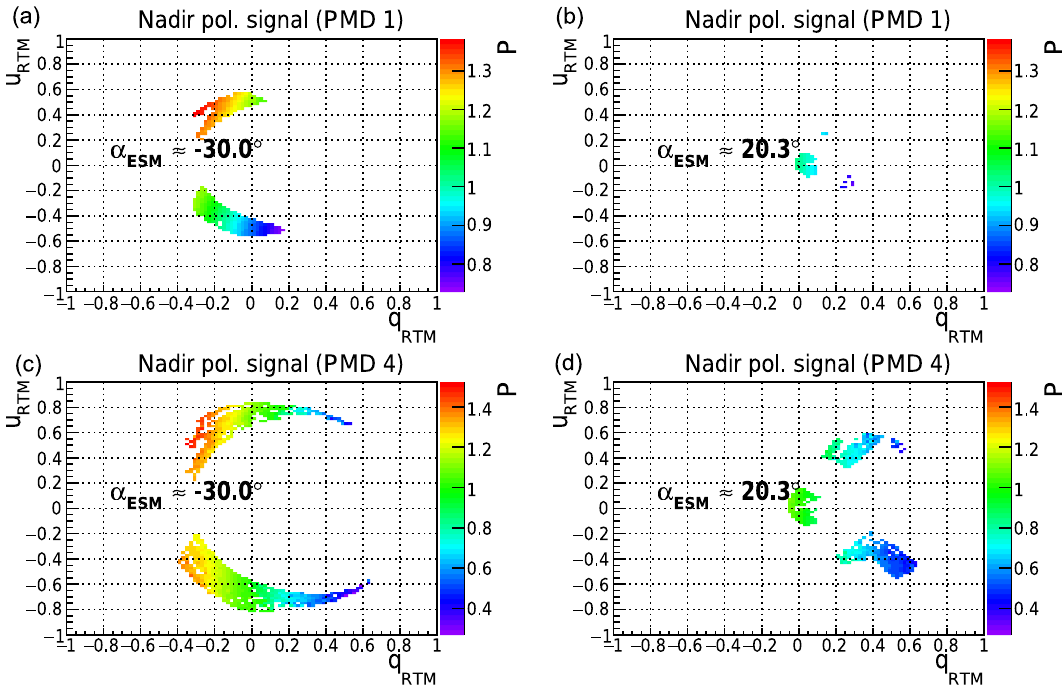
Figure 4. Polarization signals for nadir (rainbow color code) vs. q RTM ( x axis) and u RTM ( y axis) over ocean in 2004 from the extrapolation method for PMD 1 (a, b) , PMD 4 (c, d) and for two different ESM mirror positions during the nadir scan ( a, c : east; b, d :